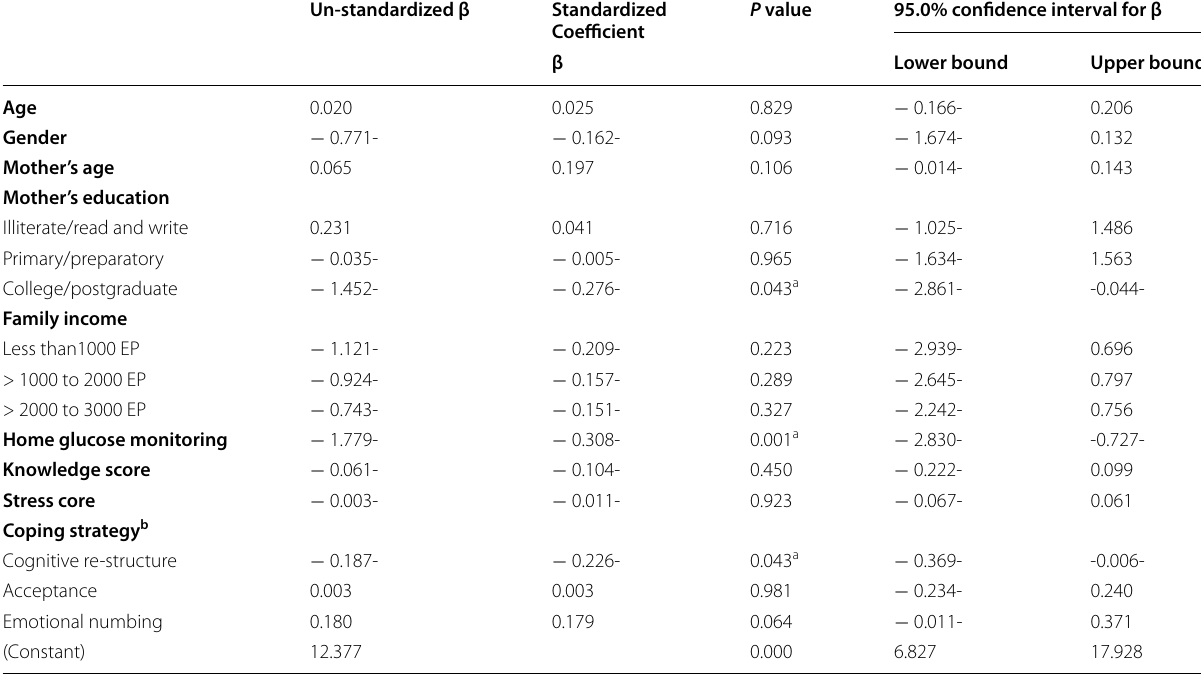
Table 5 Linear regression analysis between child’s factors, maternal factors, and child’s HbA1c (dependent